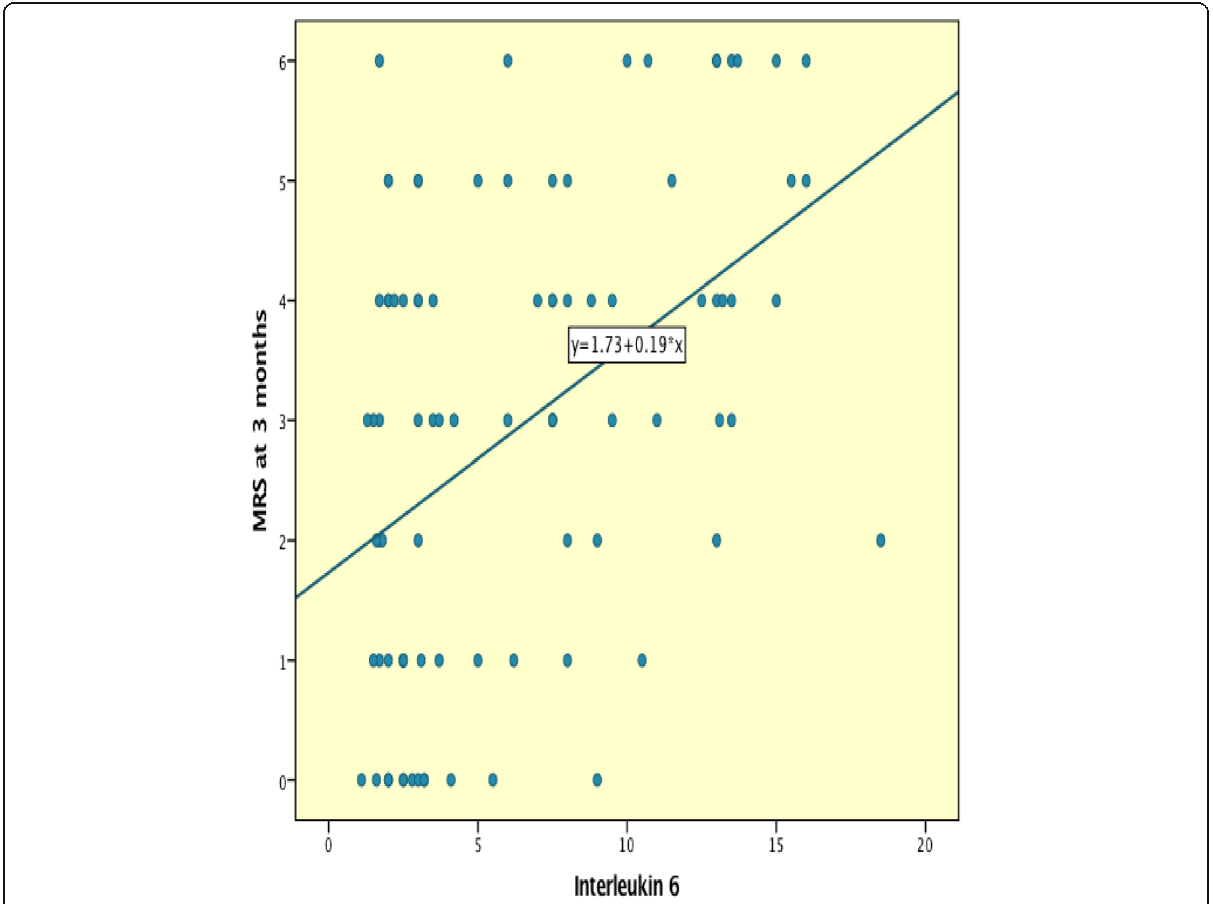
Fig. 2 Graphic representation of the correlation between mRS after 3 months and IL-6. There was a significant positive correlation between IL-6 and mRS after 3 months ( P < 0.0001) ( r =